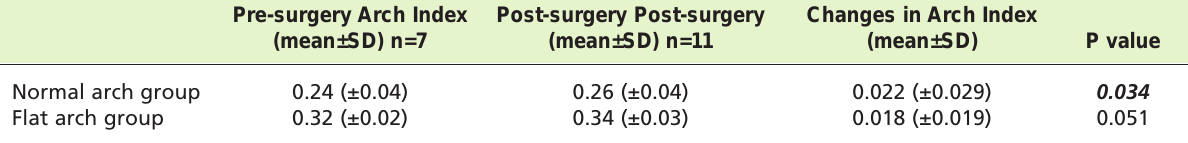
Comparison of Arch Index changes in normal arch group and flat arch group pre- and post-surgery Table III: Pre-surgery Arch